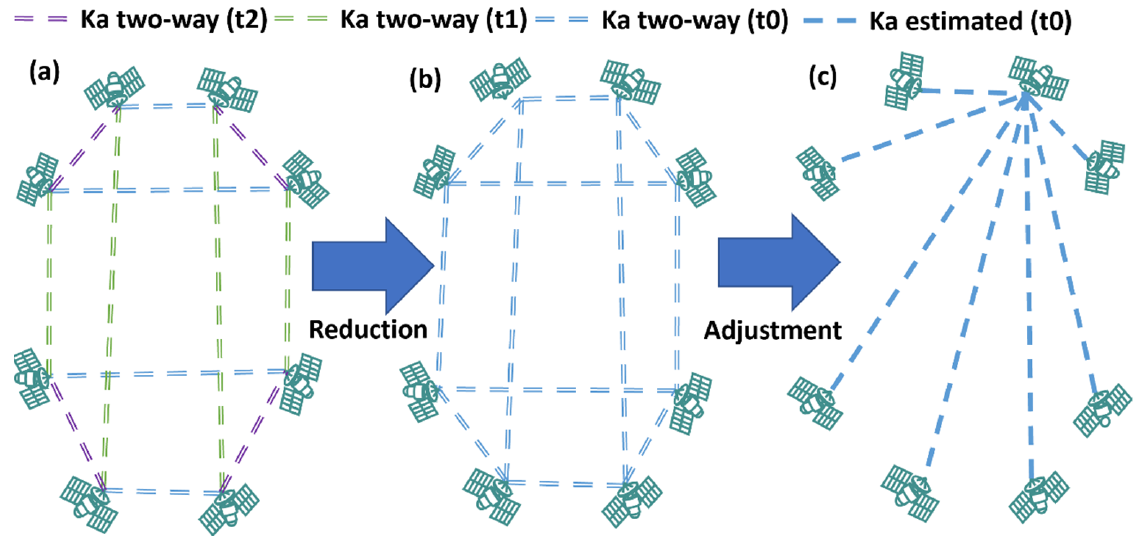
Figure 5. The procedure of the inter-satellite clock offset estimation. Wherein, t0, t1, t2 are different epoch within 60 s. Ka two-way is the Ka-band two-way clock offsets. Despite their epoch are differ- ent (as ( a )), they can be reduced to the same epoch by prior message (as ( b )) for further adjustment processing in the new strategy (as ( c )).